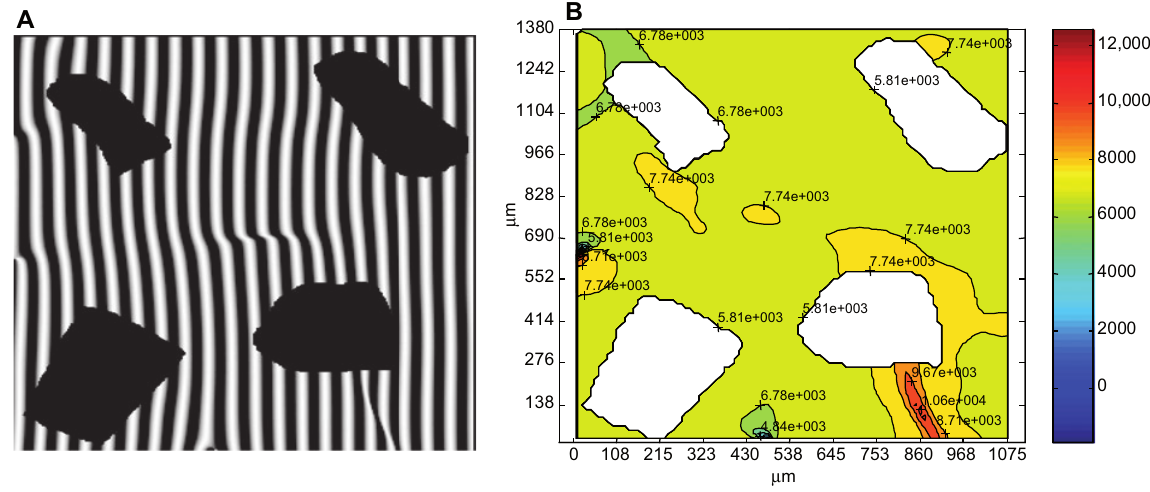
Figure 3 (A) Moir é fringe pattern in the u-direction. (B) Strain component for same